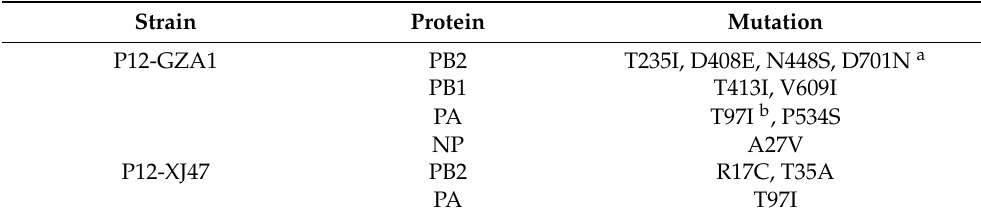
Table 4. Mutations in amino acid sites of two mice adaptation strains of the two H3N8 AIV strains. Strain Protein Mutation